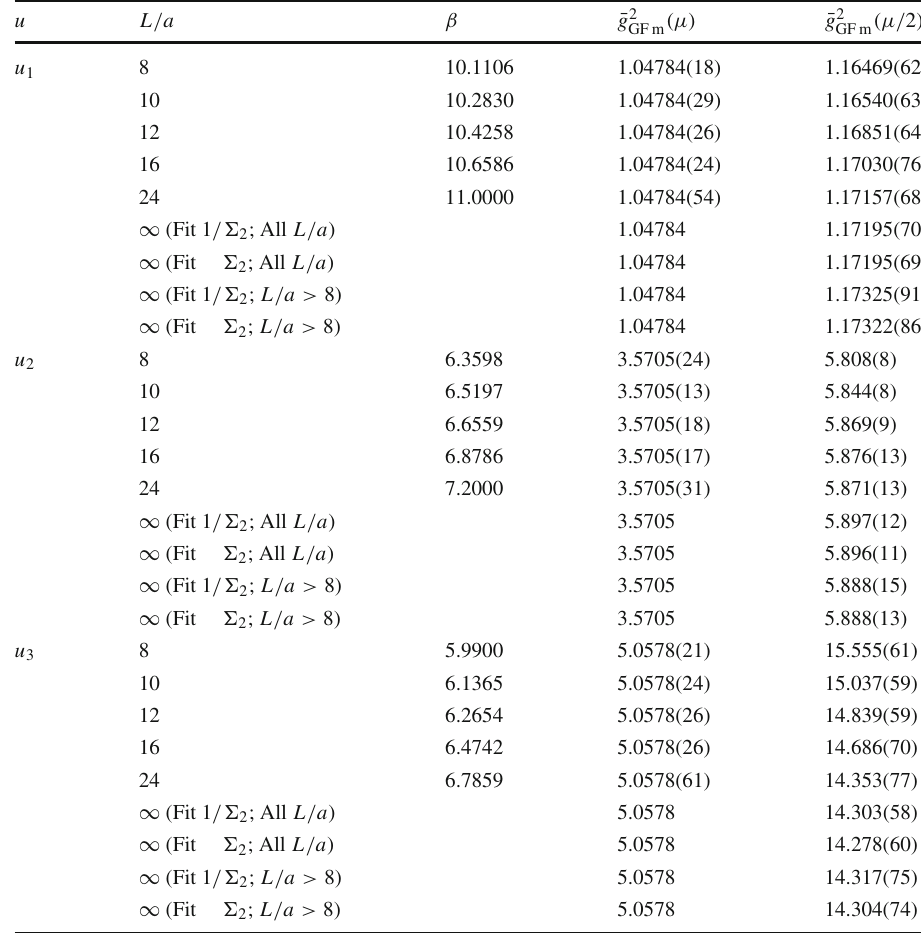
Table 6 Data for the lattice step scaling function, (cid:15) 2 ( u , a / L ) , of the magnetic GF coupling, at the target couplings of Eq.